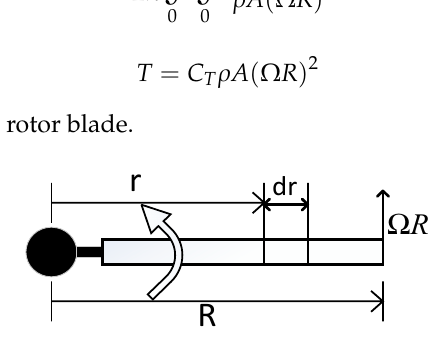
Figure 3. Model of a blade element.